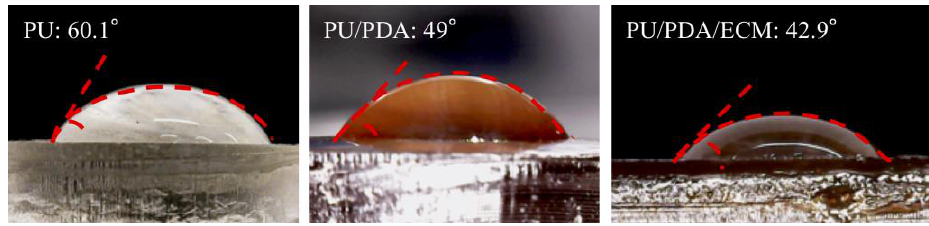
Figure 2. The water contact angle of PU, PU/PDA, and PU/PDA/ECM specimens.